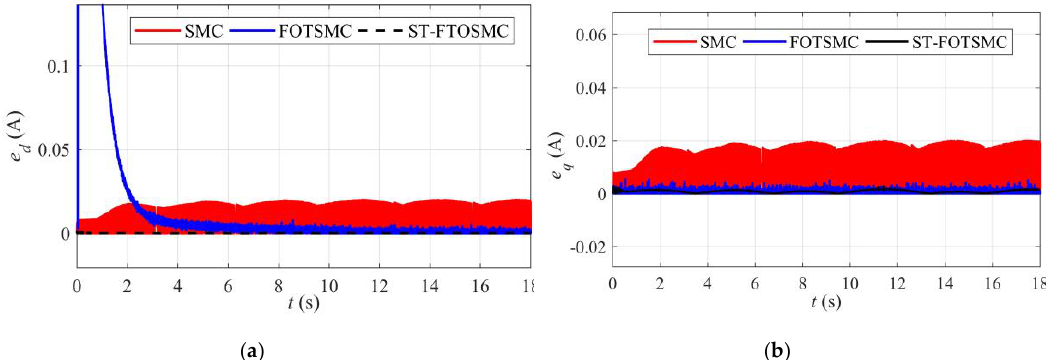
Figure 13. ( a ) 𝑒 𝑑 under lumped uncertainties; ( b ) 𝑒 𝑞 under lumped uncertainties. Figure 13. ( a ) e d under lumped uncertainties; ( b ) e q under lumped uncertainties.